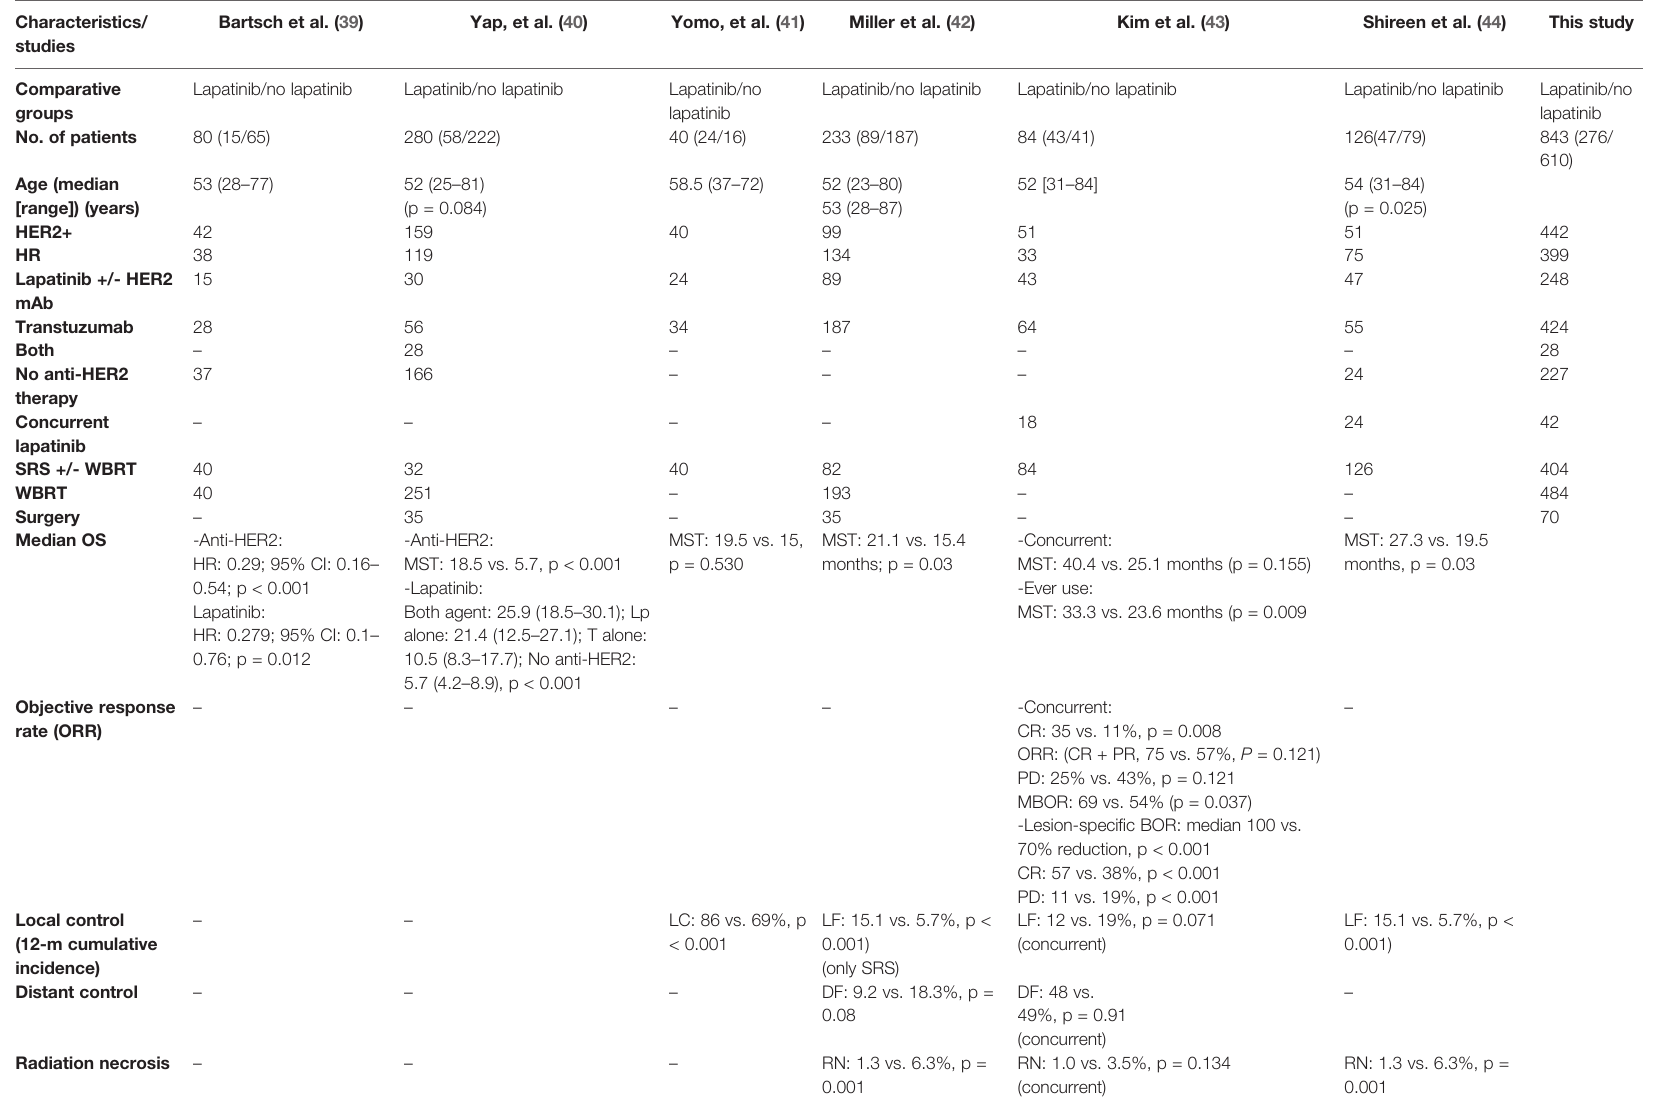
TABLE 2 | Baseline characteristics of patients and main outcomes of interest. Characteristics/